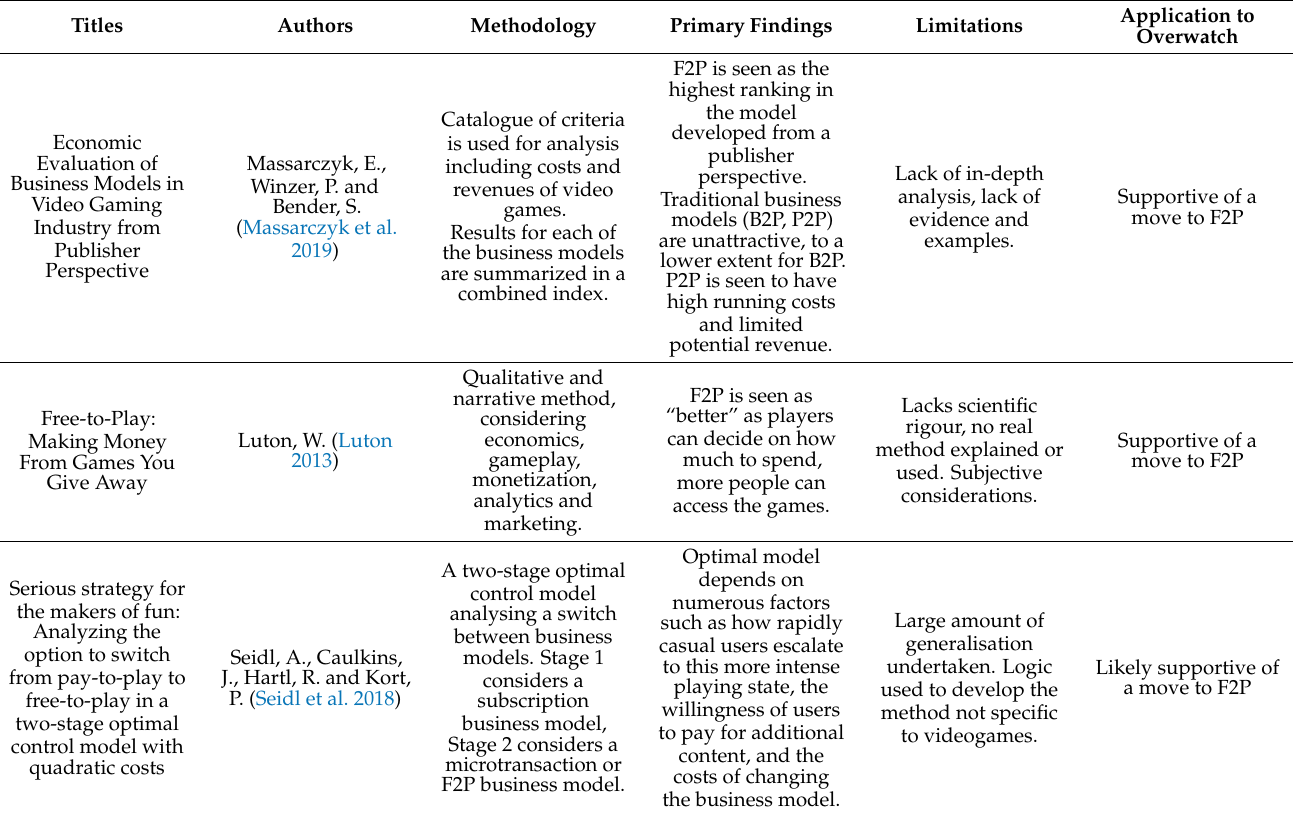
Table 4. Summary of seminal research